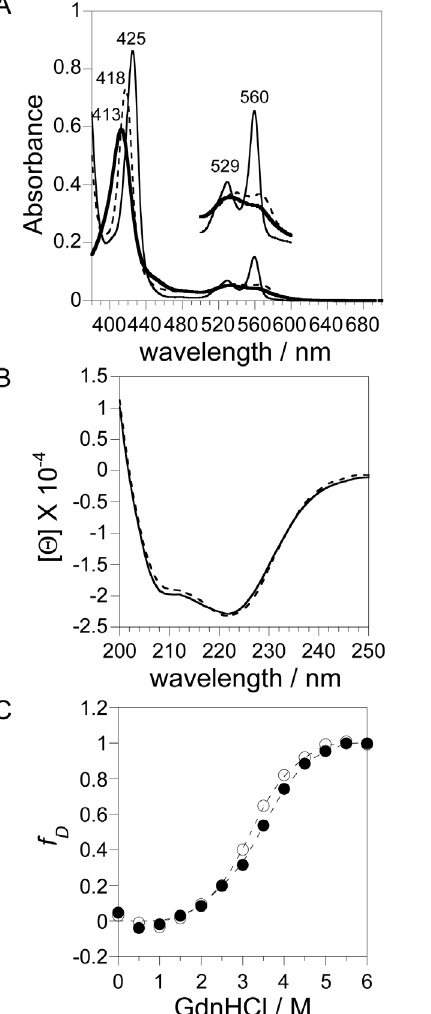
Figure 2. Effect of the E60Q mutation in human Ngb upon structure. (A) Electronic absorption spectra of the ferric (bold line), ferrous deoxy (fine line), and ferrous CO-bound (dotted line) forms of human E60Q Ngb. The Q bands from 500 to 600 nm are enlarged by a factor of 3 on the perpendicular axis. The spectra were recorded in PBS (pH 7.4) at ambient temperature ( , 20 u C). (B) CD spectra in the far UV region of the ferric form of the WT Ngb (dotted line), and E60Q Ngb (fine line). The concentration of each protein was approximately 5 m M on the basis of heme content. The spectra were recorded in 50 mM sodium phosphate buffer (pH 7.4) at 20 u C. (C) GdnHCl denaturation curves of human WT and E60Q Ngb. Denaturation curves were measured for human WT (open circle), and E60Q (closed circle) Ngb. Molecular ellipticities at 222 nm in the native and completely denatured states were normalized to 0 and 1, respectively. The concentration of each protein was 5 m M on the basis of heme content.